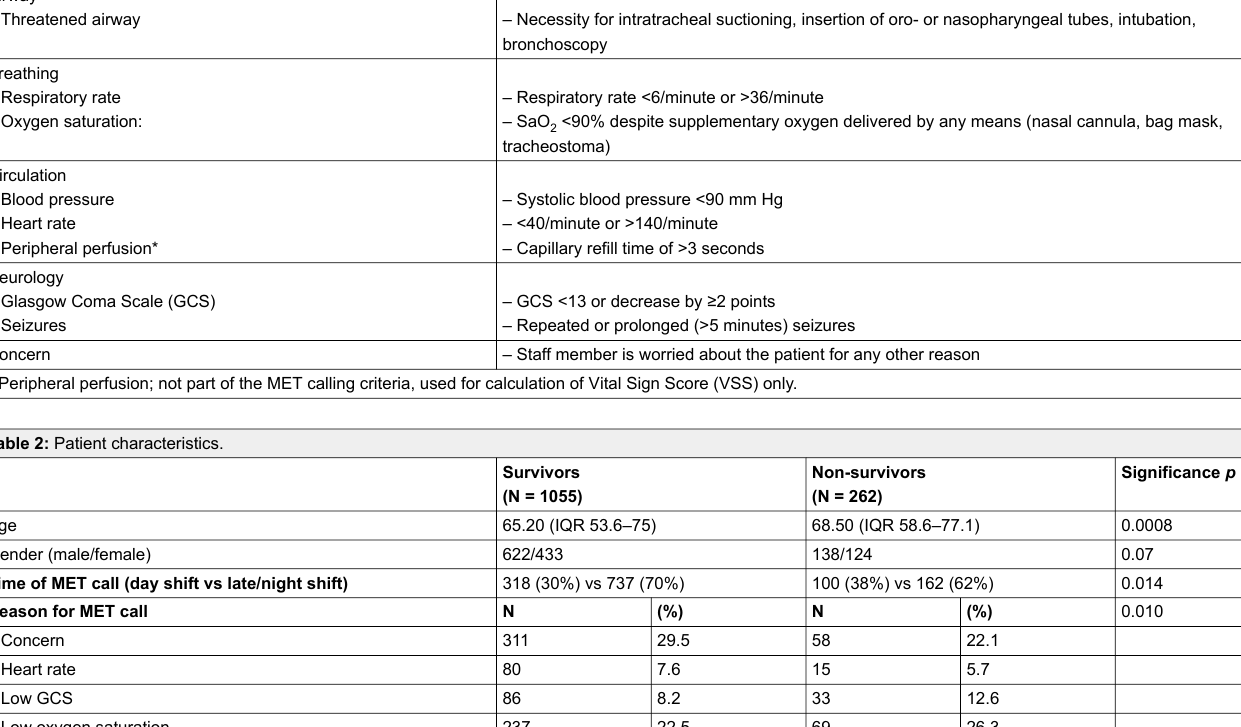
Table 1: MET calling criteria used by the University Hospital Bern (Inselspital).